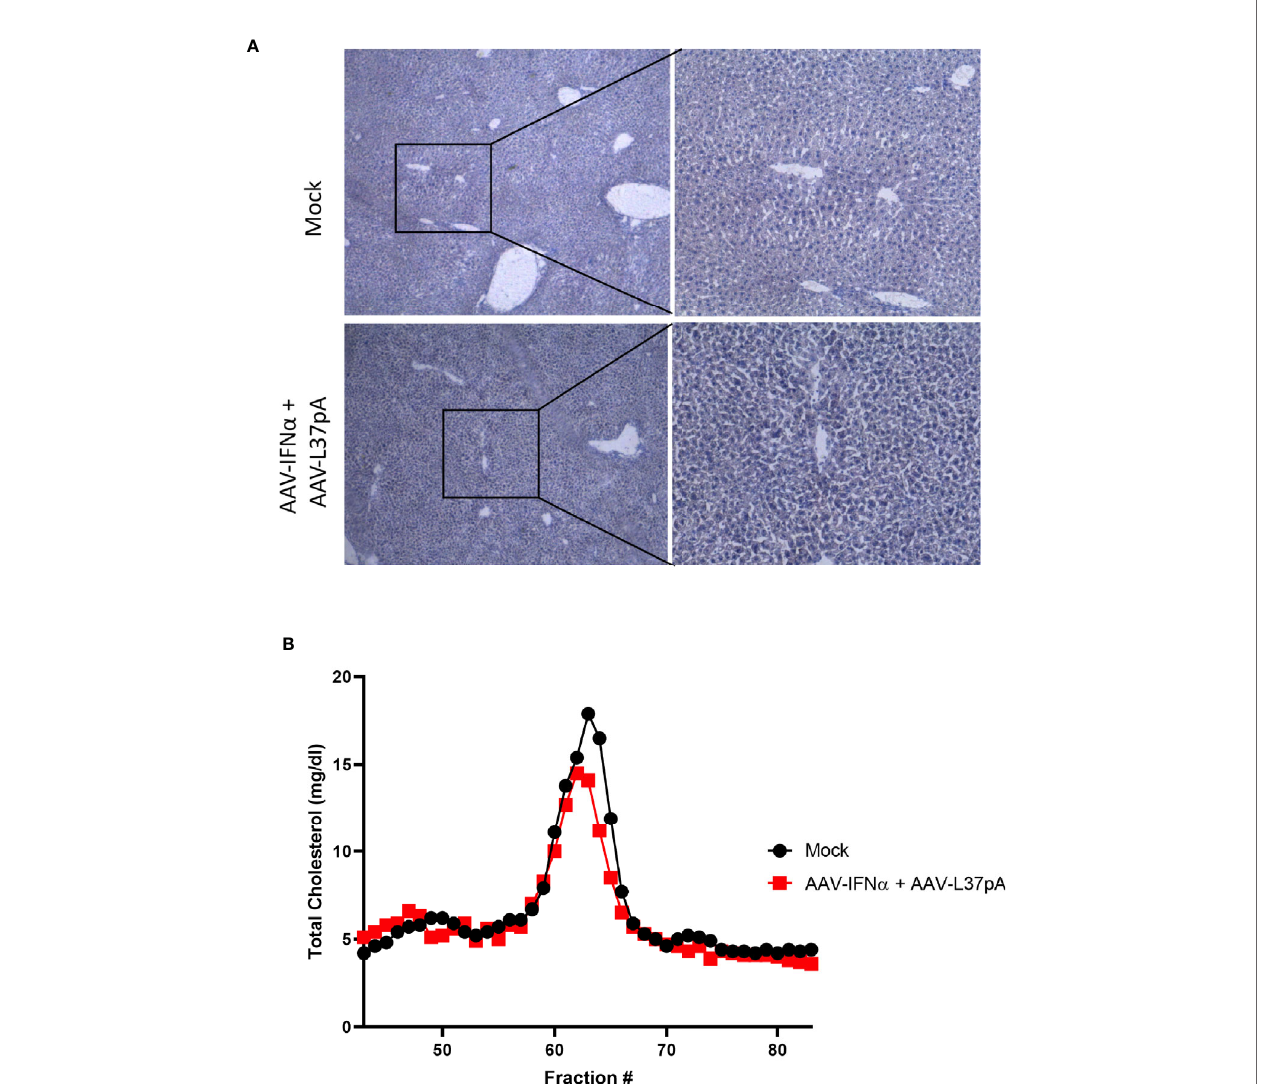
FIGURE 6 | Long-term effect on lipid accumulation in the liver and on plasma lipoprotein pro fi le. C57BL/6 mice (N = 6) were left untreated (mock) or received 1.2x10 11 vg/mouse of AAV-IFN a combined with 9.5x10 11 vg/mouse AAV-L37pA. Mice were followed for 120 days and then sacri fi ced. (A) Lipid accumulation in the liver was analyzed by Fat Red staining. Representative images. (B) Lipoprotein pro fi le of mice after fast protein liquid chromatography followed by cholesterol determination in the different